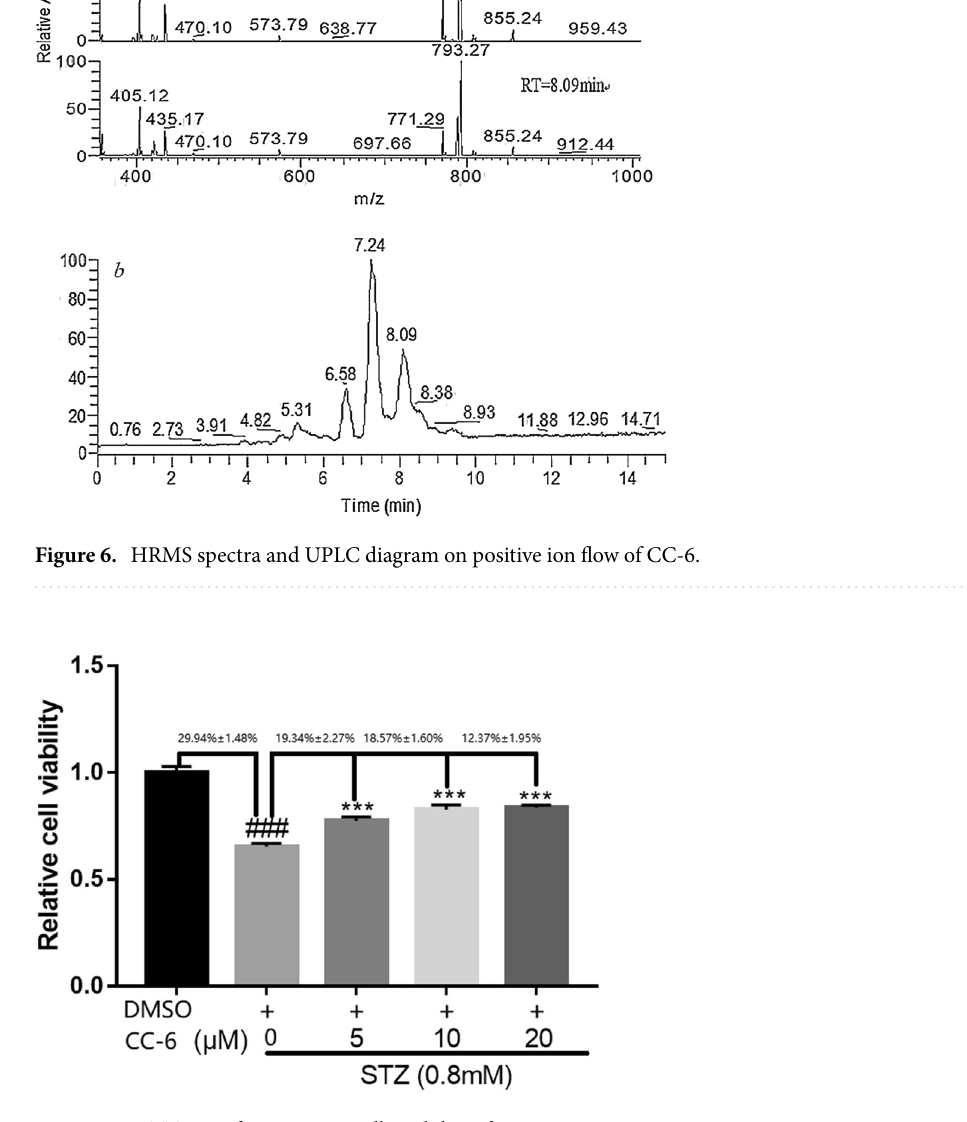
Figure 7. MTT assay for SH-SY5Y cells viability of